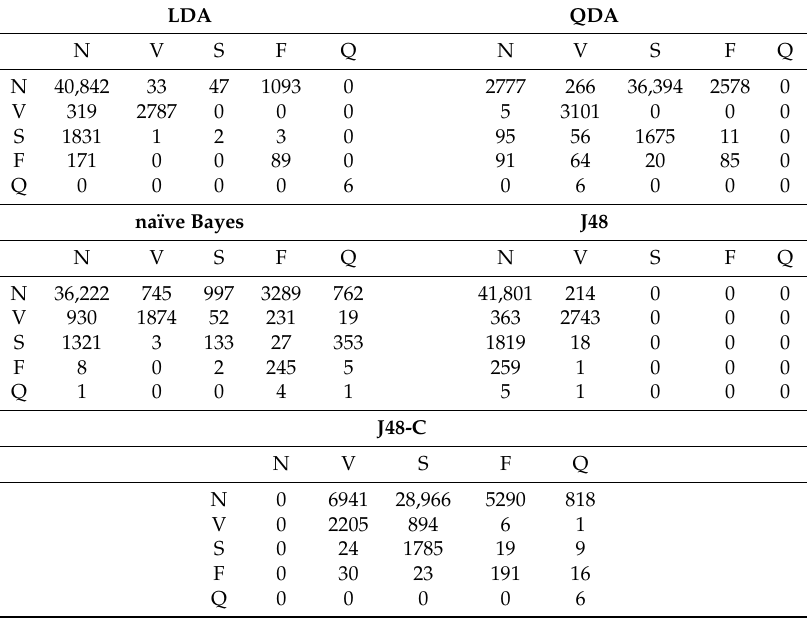
Table 6. Confusion matrices for LDA, QDA, naïve Bayes, J48, and J48-C classifiers.